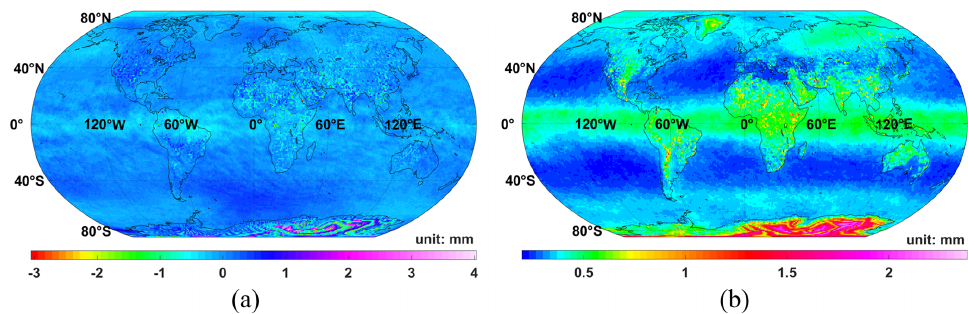
Figure 8. MABs over July (a) and the whole year (b) of 2020 after correction by the grid model.